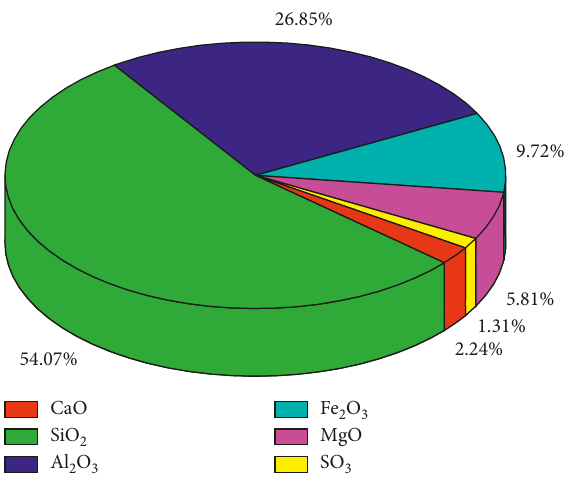
Figure 1: Main chemical composition of fly Table 1: The orthogonal experimental design.